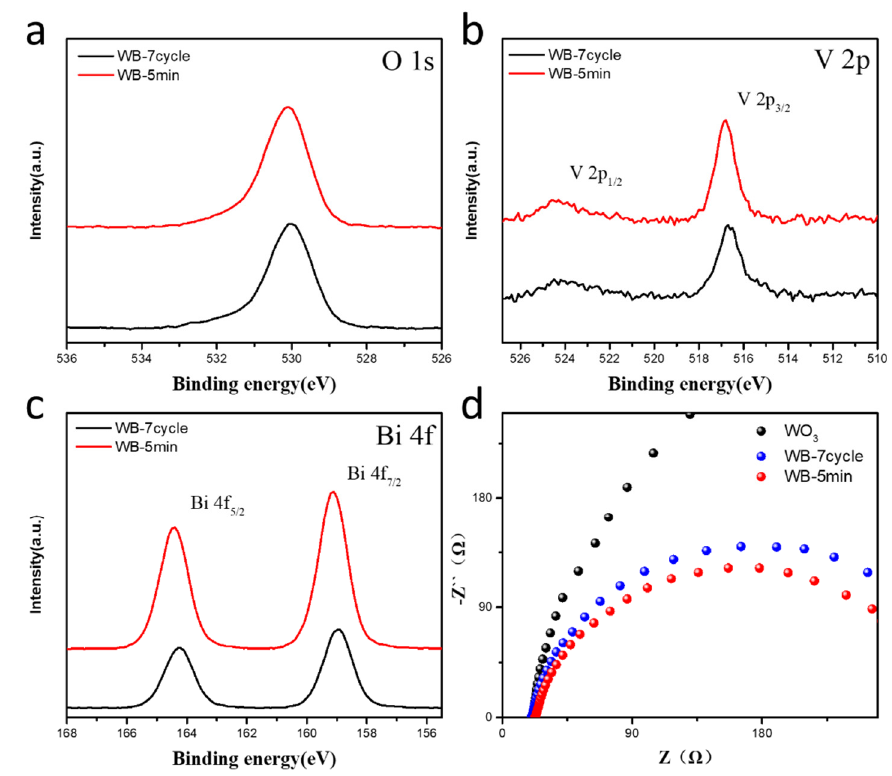
Figure 6. XPS spectra with ( a ) O 1s, ( b ) V 2p and ( c ) Bi 4f signals of WB-7cycle and WB-5min samples. ( d ) EIS plots of WO 3 , WB-7cycle, and WB-5min samples.